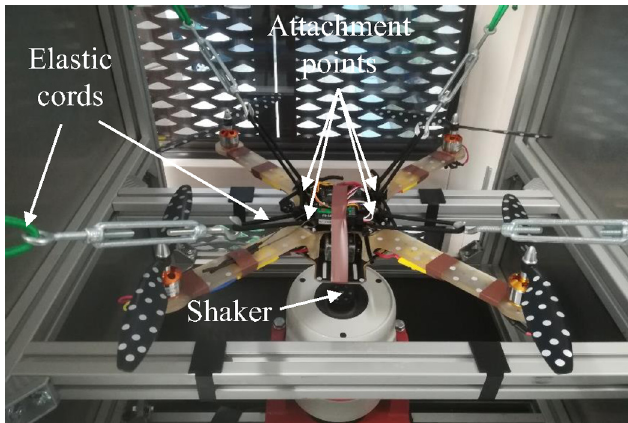
Fig. 6. Installation of the revised drone in “ free-free ” conditions, the motors were off.